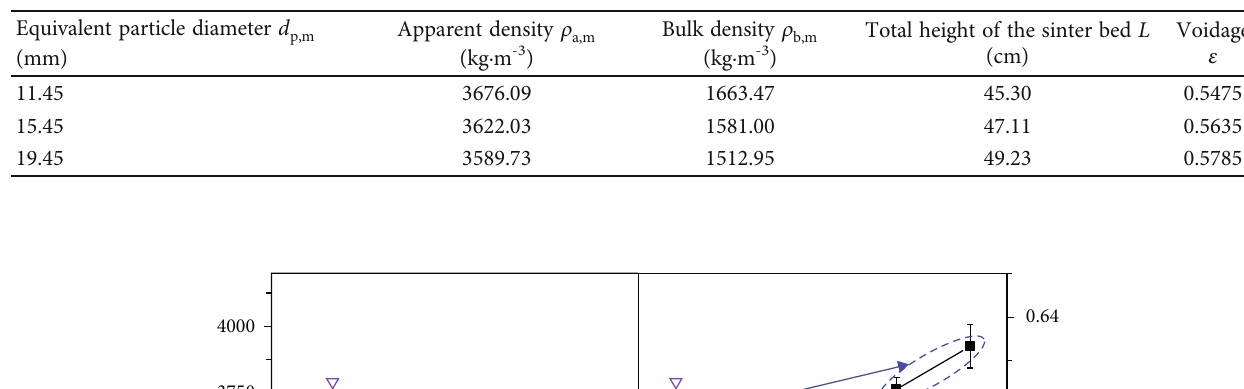
Table 2: Characteristic parameters of the three kinds of sinter mixtures.